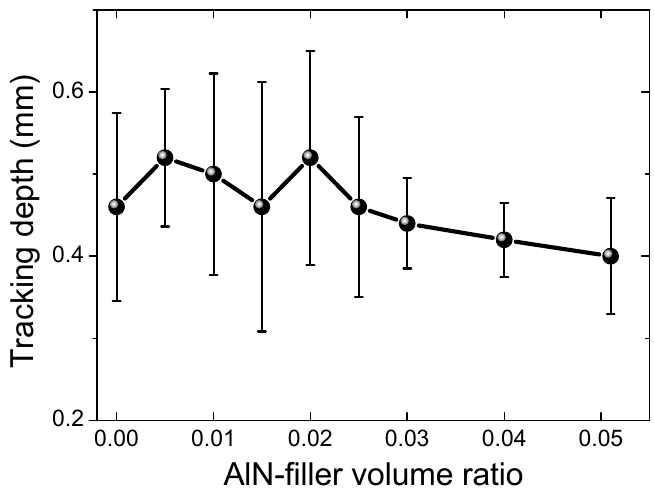
Figure 7. Electrical tracking and erosion measurement results (depth in mm) of the AlN-filled silicon rubber samples.